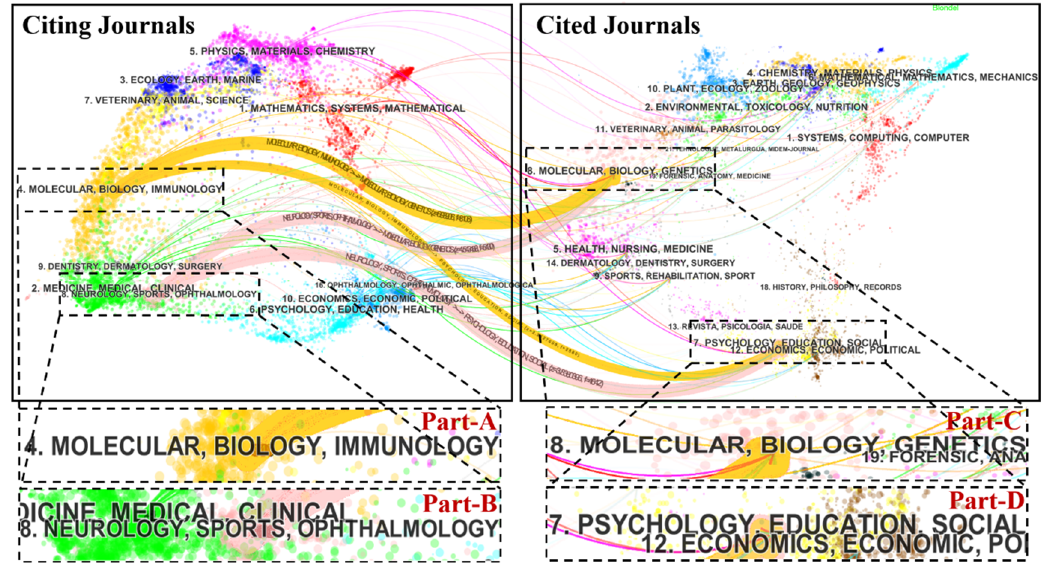
Figure 5. A dual-map overlay of journals that published work related to CTE. A presentation of citation paths at a disciplinary level on a dual-map overlay. The width of the paths is proportional to the z-score-scale citation frequency.